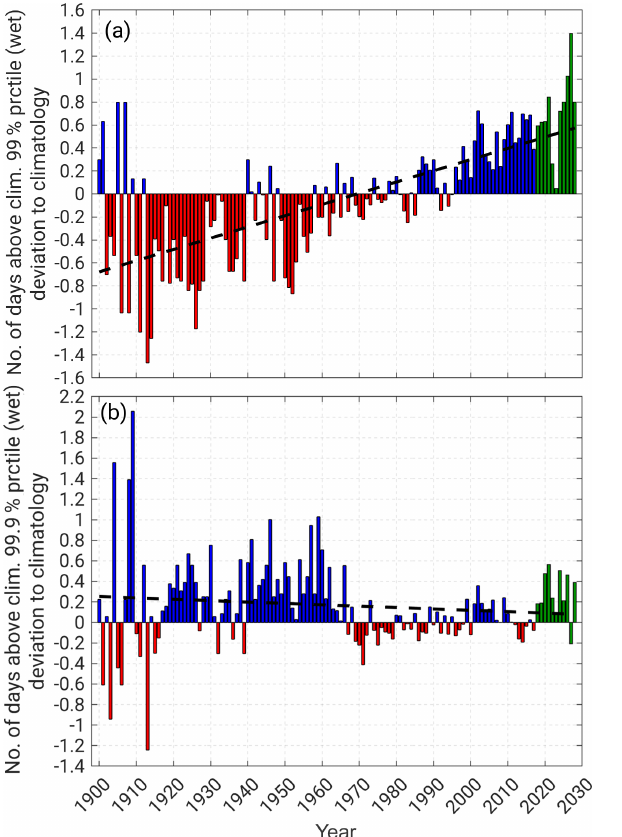
Figure 8. Deviation of the LAERTES-EU ensemble mean of the yearly number of days above the 99th percentile (wet days only) of daily spatial mean precipitation compared to the clima- tology (climTP; 1961–1990) for (a) Mid-Europe (ME) and (b) the Alps (AL). Red bars indicate negative anomalies (less days); blue bars indicate positive anomalies (more days). The predictions (TP2; 2018–2028) are given in green. The black line indicates a lin- ear